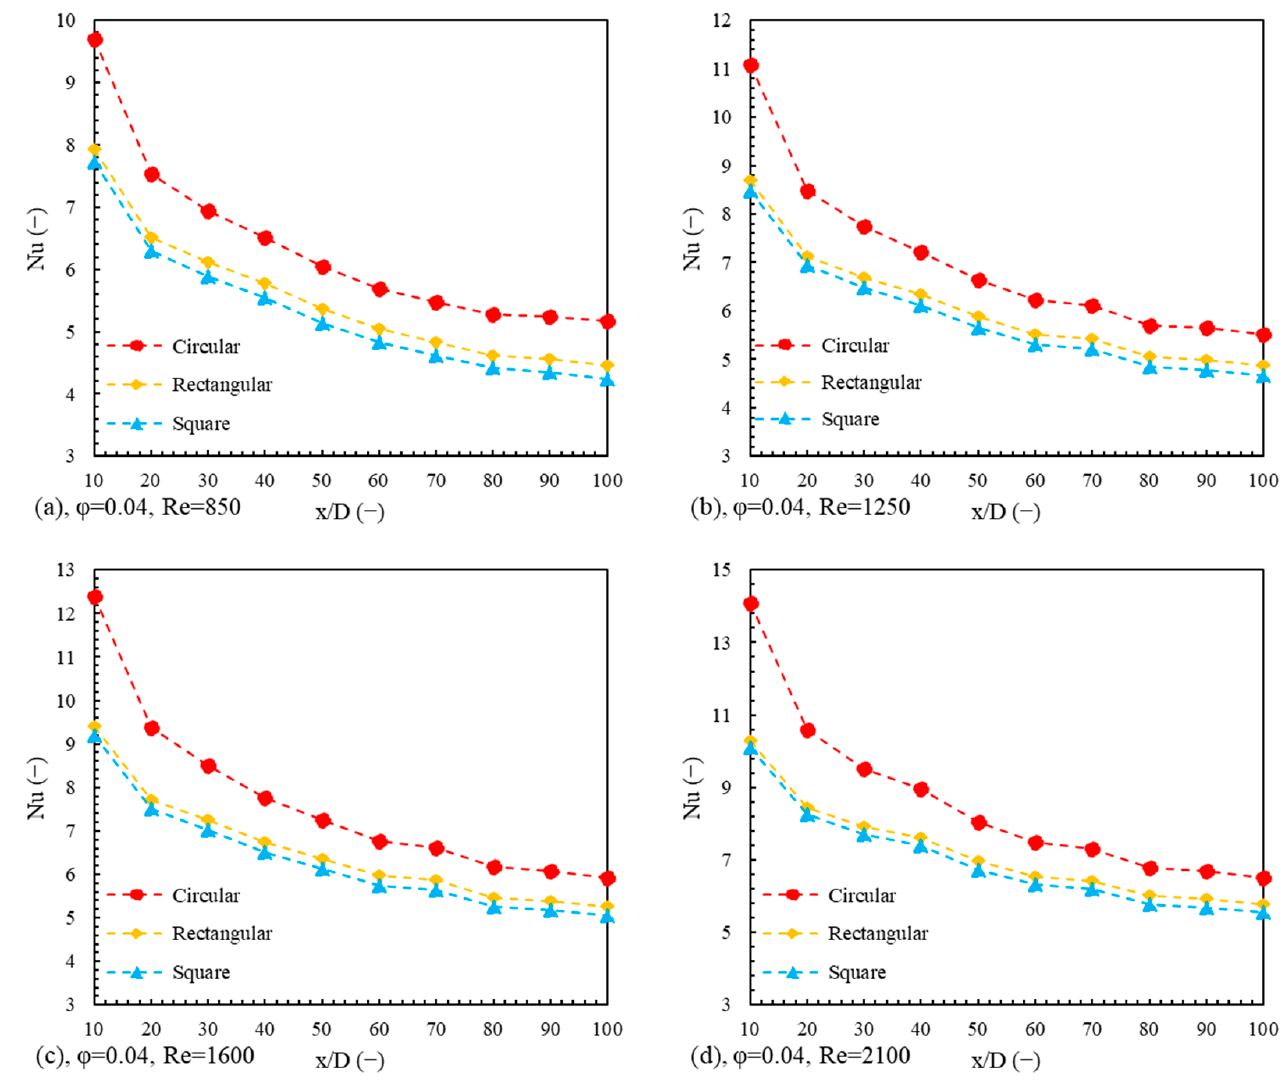
Figure 7. Local Nu of 4% nanofluid with different cross-sections in ( a ) Re = 850, ( b ) Re = 1250, Figure 7. Local 𝑁𝑢 of 4% nanofluid with different cross-sections in ( a ) 𝑅𝑒 = 850 , ( b ) 𝑅𝑒 = 1250 , ( c ) Re = 1600, and ( d ) Re = ( c ) 𝑅𝑒 = 1600 , and ( d ) 𝑅𝑒 = 2100 .